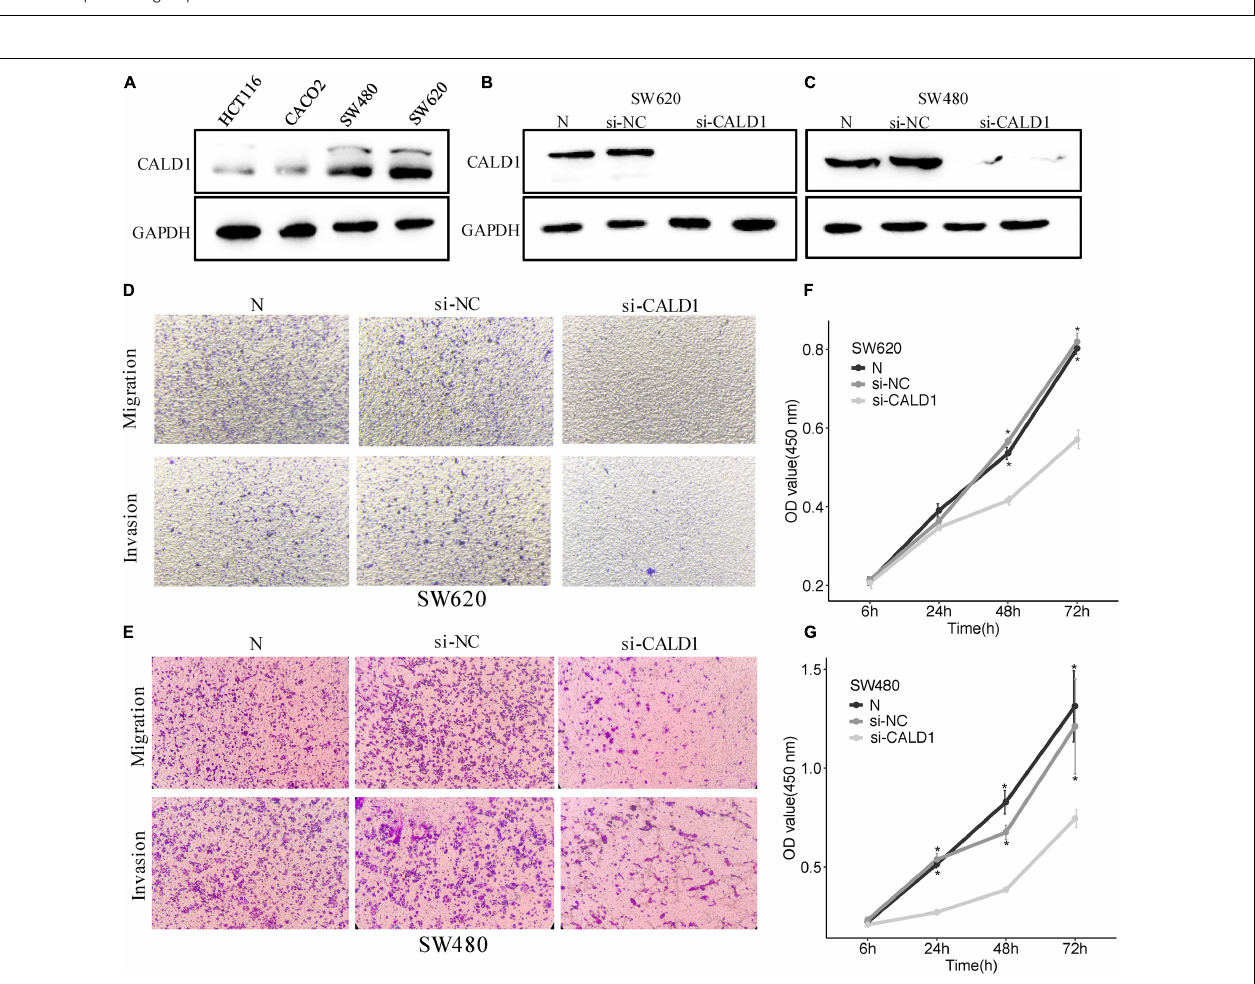
FIGURE 7 | Gene Sets Enrichment Analysis (GSEA) revealed that several immune-related (A) and tumor-related (B) pathways were highly enriched in the high CALD1 expression group.